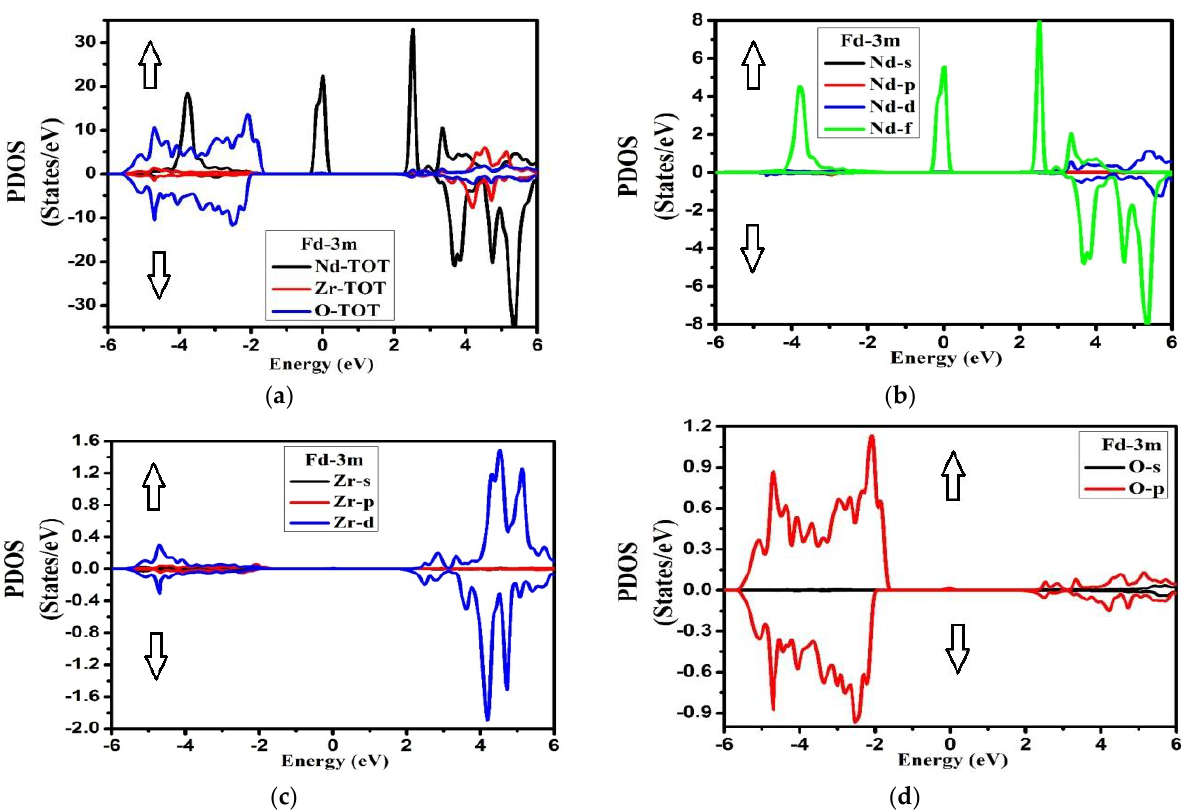
Figure 5. Partial density of states ( a ) Nd-TOT, Zr-TOT, O-TOT; ( b ) Nd-s,p,d,f; ( c ) Zr-s,p,d; ( d ) O-s,p for Nd 2 Zr 2 O 7 in the Fd-3m phase for the spin-up direction ( ↑ ) and spin-down ( ↓ ) direction.